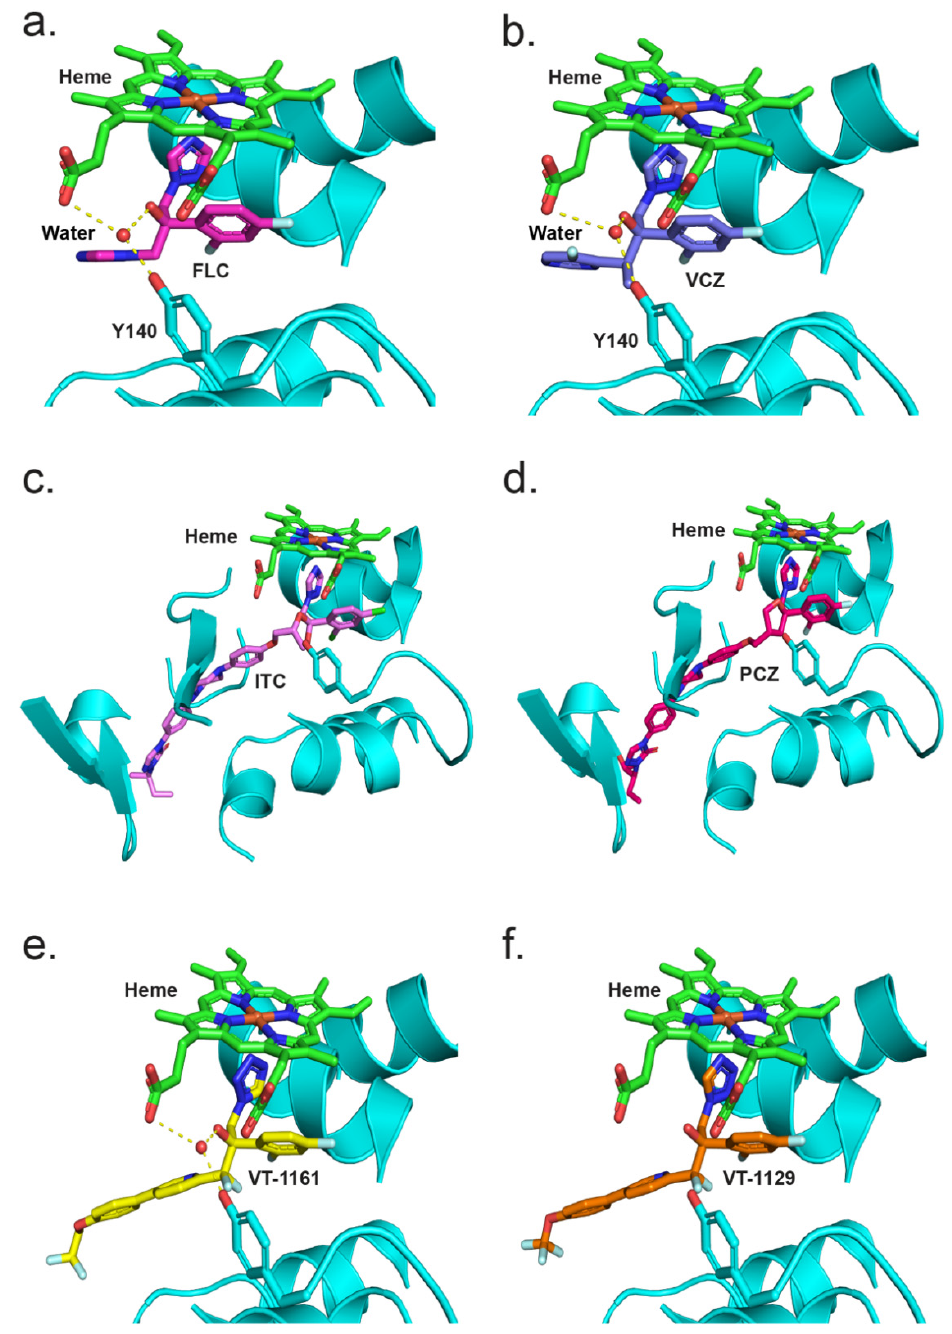
Figure 8. The CpCYP51 model (cyan cartoon) superimposed with ScCYP51 structures complexed with ( a ) FLC (PDB ID: 4WMZ), ( b ) VCZ (PDB ID: 5HS1), ( c ) ITC (PDB ID: 5EQB), ( d ) PCZ (PDB ID: 6E8Q), ( e ) VT-1161 (PDB ID: 5UL0), and ( f ) VT-1129 (PDB ID: 7RYX). Only ligands and selected water molecules from known ScCYP51 structures are shown.